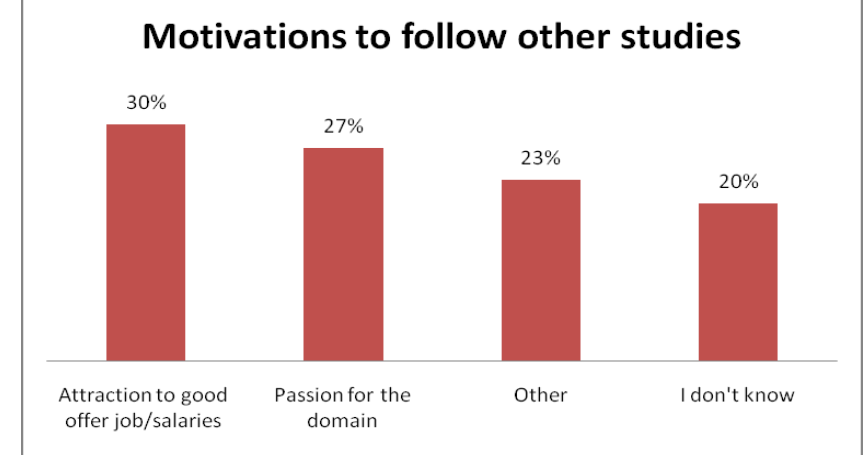
Figure 4. Motivations to follow studies outside CS in percentage. Answers from the students not involved in CS (Target two: 38% of the total